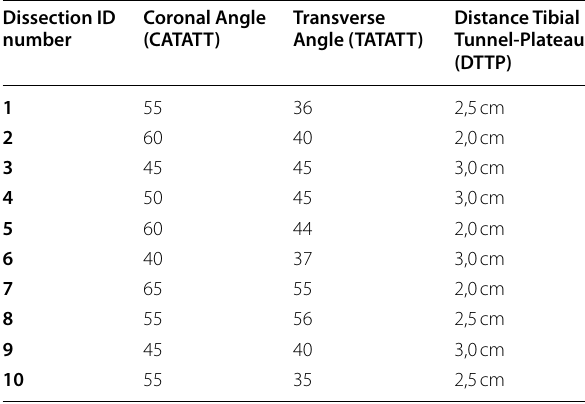
Table 1 Coronal and transverse angle, and tunnel-plateau distance for each